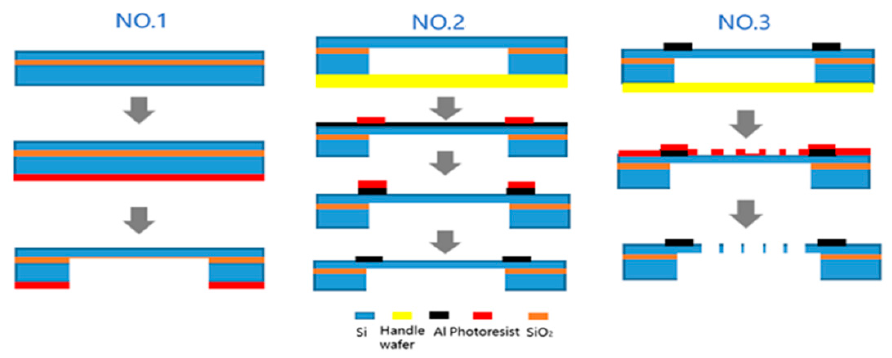
Figure 11. The processing scheme. Table 3. Flow and operation of the process.